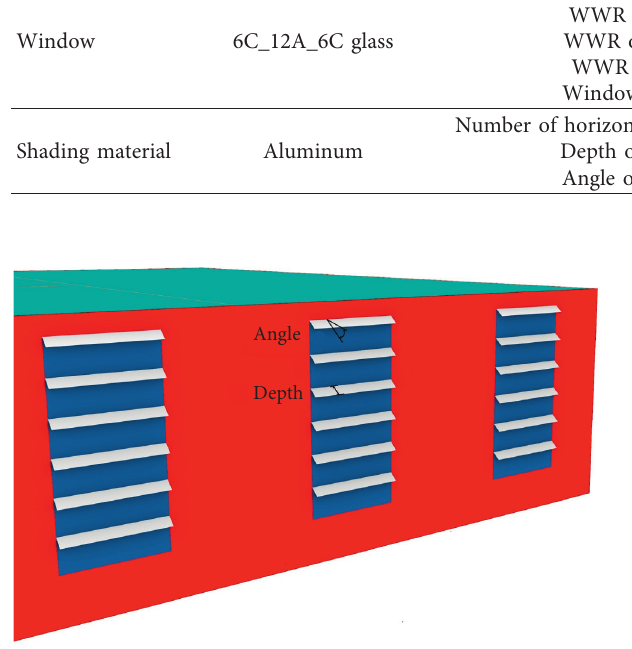
Figure 1: Layout of louver depth and angle.